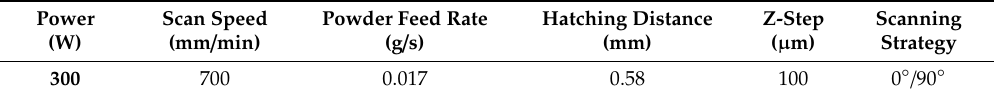
Table 1. Set of building parameters used to build the cubic Ti-6Al-4V